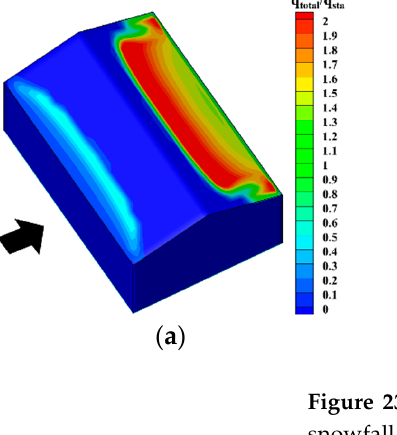
Figure 22. Spatial distribution of the normalized deposition flux of drifting snow q surf / q sta with dif- ferent snowfall intensities: ( a ) volume fraction: 7.8 × 10 − 6 ; ( b ) volume fraction: 1.56 × 10 − 5 ; ( c ) volume fraction: 2.34 × 10 − 5 .